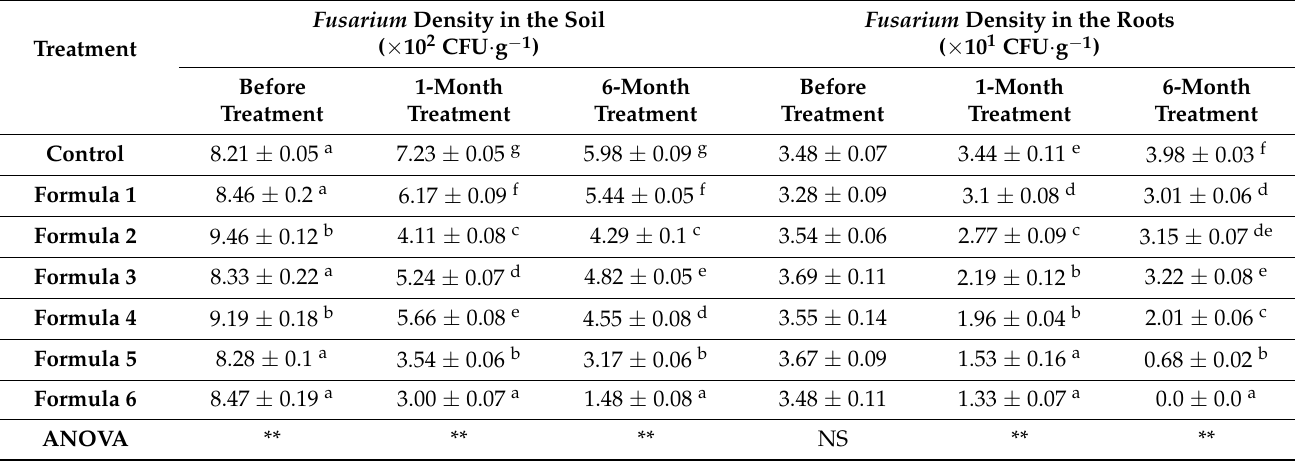
Table 5. Fusarium spp. density in the soil and in the roots of black pepper before and after treatment with bio-products. Fusarium Density in the Treatment